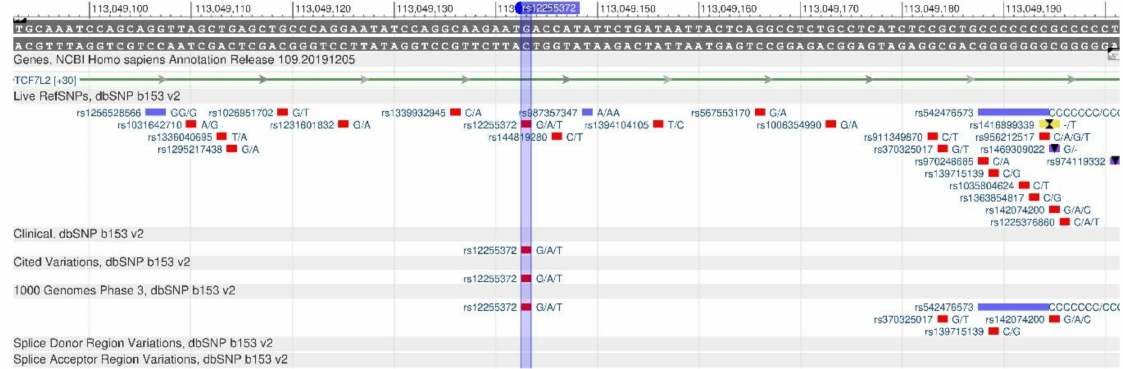
Figure 3. The TCF7L2 gene region (located on the long (q) arm of chromosome 10) containing the oligonucleotide polymorphism rs12255372.